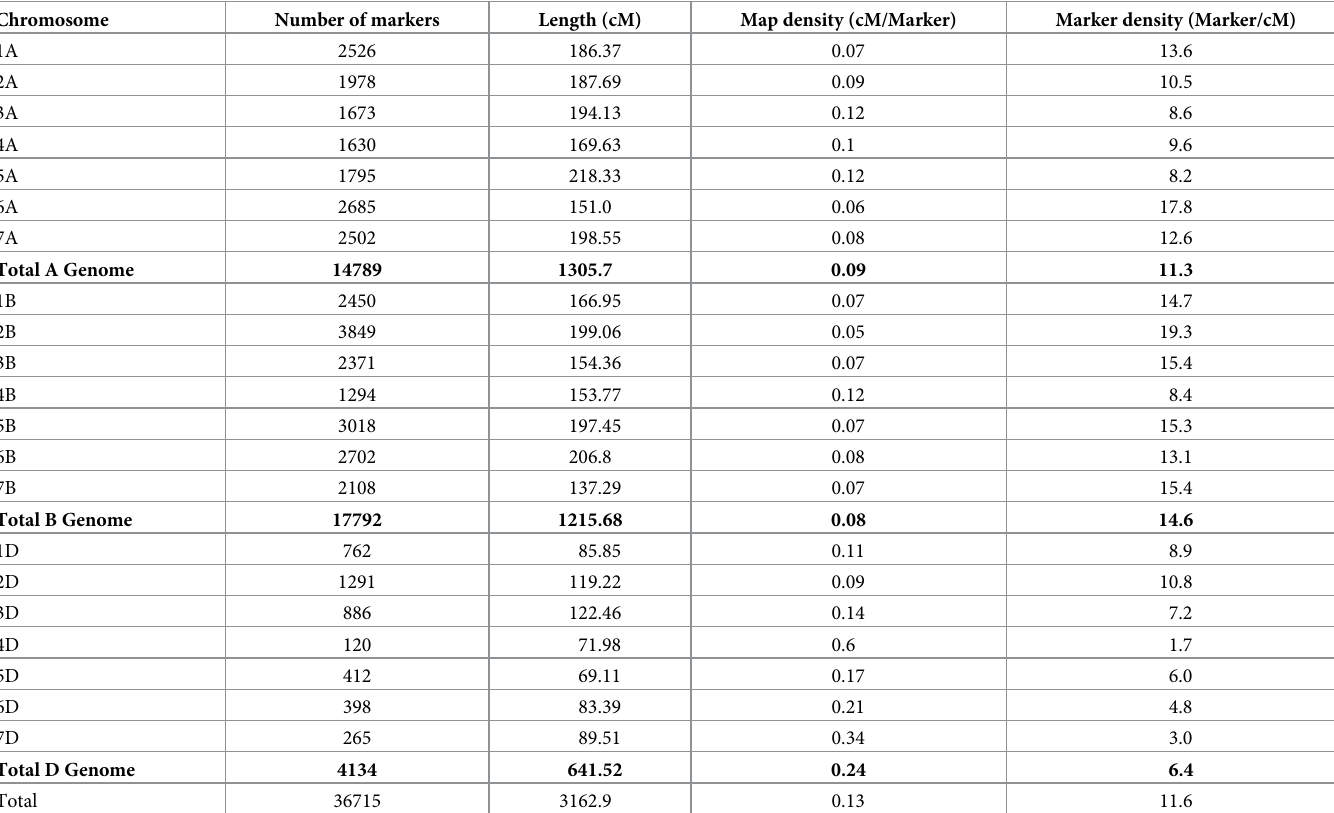
Table 3. Statistics characterizing totals as well as individual chromosomes of the consensus map built from 14 hexaploid wheat populations a : Chromosome name, number of markers, map length (cM), map density and average marker spacing.